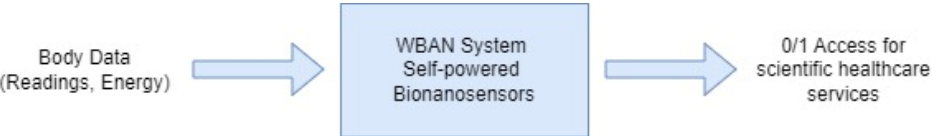
Figure 1. Problem design of the services allocation for patients.